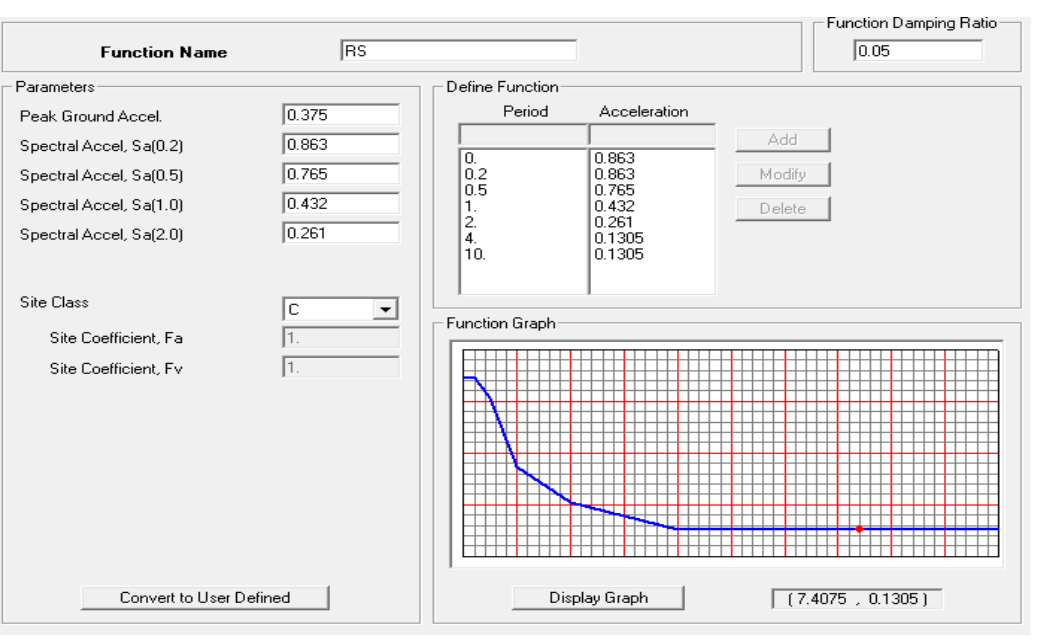
Figure 4. Design spectral acceleration used in the response spectrum analysis (NBCC-2010).